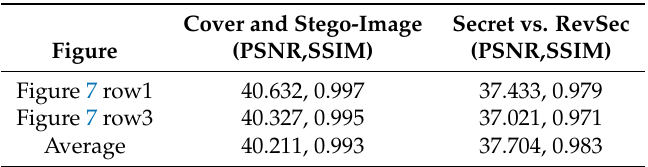
Table 3. Peak signal-to-noise ratio (PSNR) and structural similarity (SSIM) of stego-image and secret image, secret image, and RevSec image.